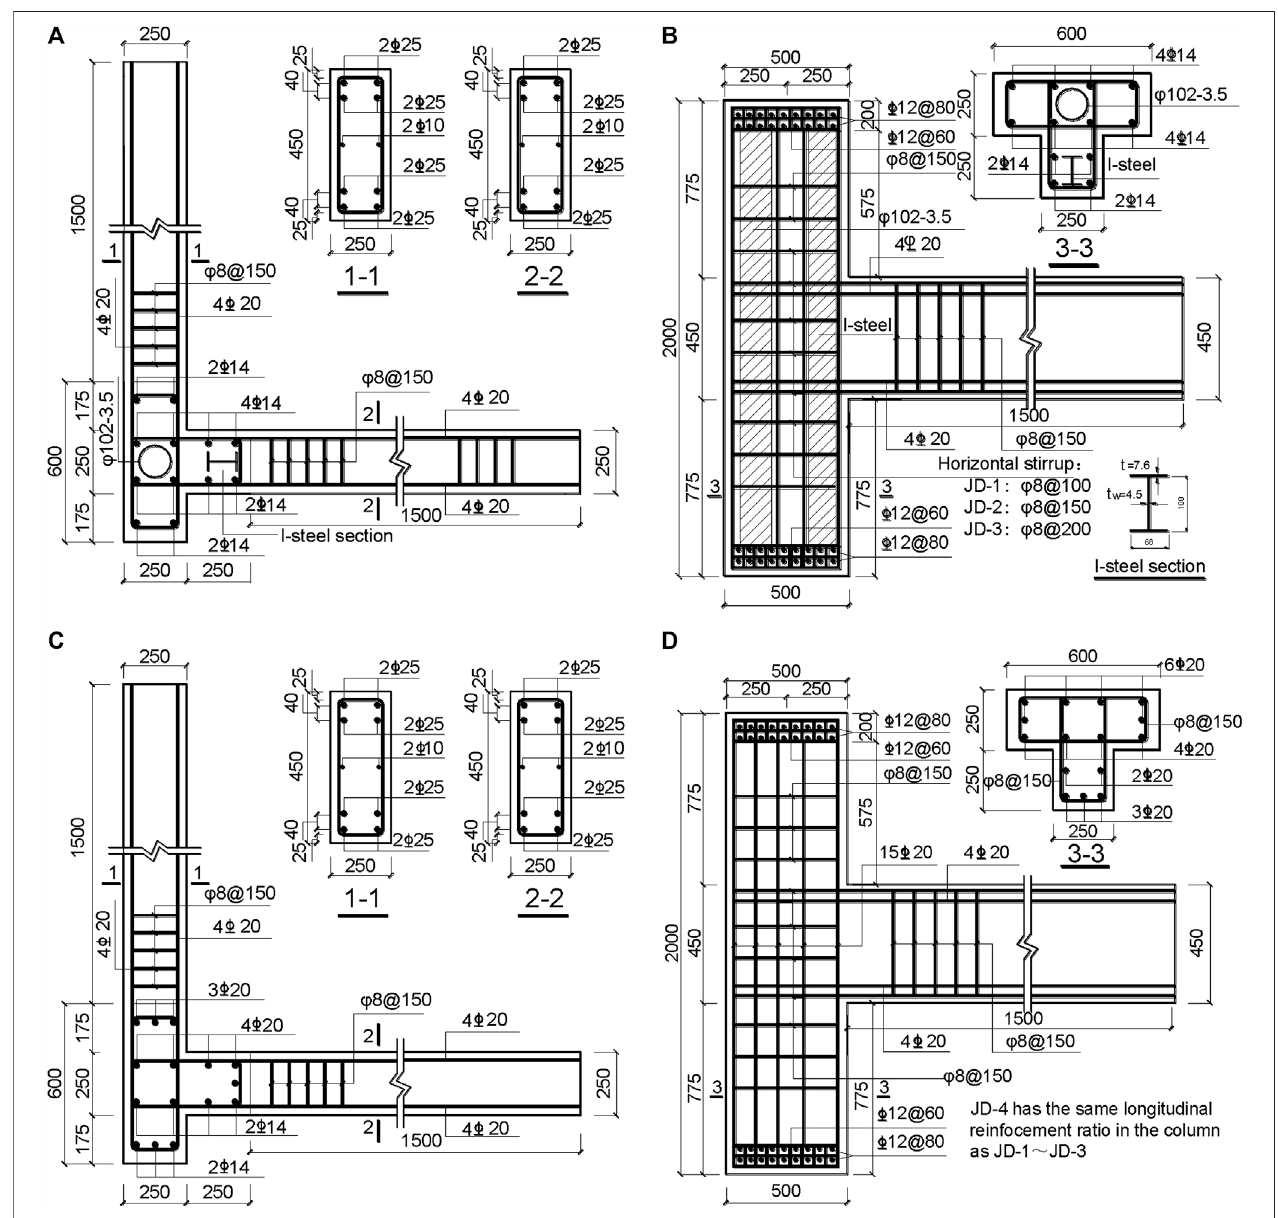
FIGURE8| Detailsofspecimens. (A) SectionreinforcementofspecimensJD-1,JD-2,andJD-3; (B) reinforcementofspecimensJD-1,JD-2,andJD-3; (C) section reinforcement of specimen JD-4; and (D) section reinforcement of specimen JD-4 (Xiang et al., 2017).